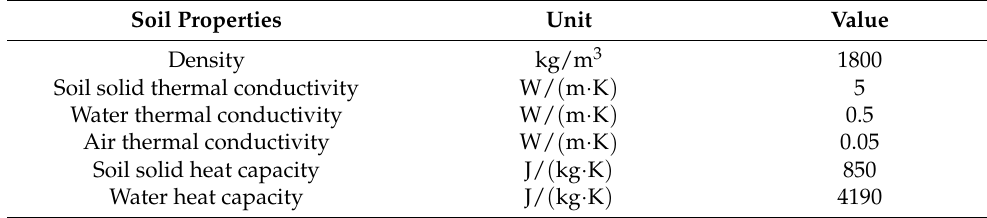
Table 1. Soil and Concrete Properties